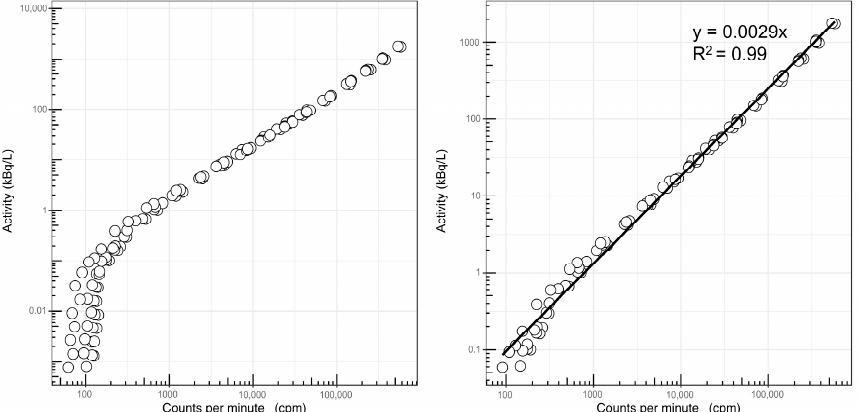
Figure 2. Measuring system calibration charts showing all measurements (circles), including long- living nuclides below 150 cpm (left) and without these nuclides (right).